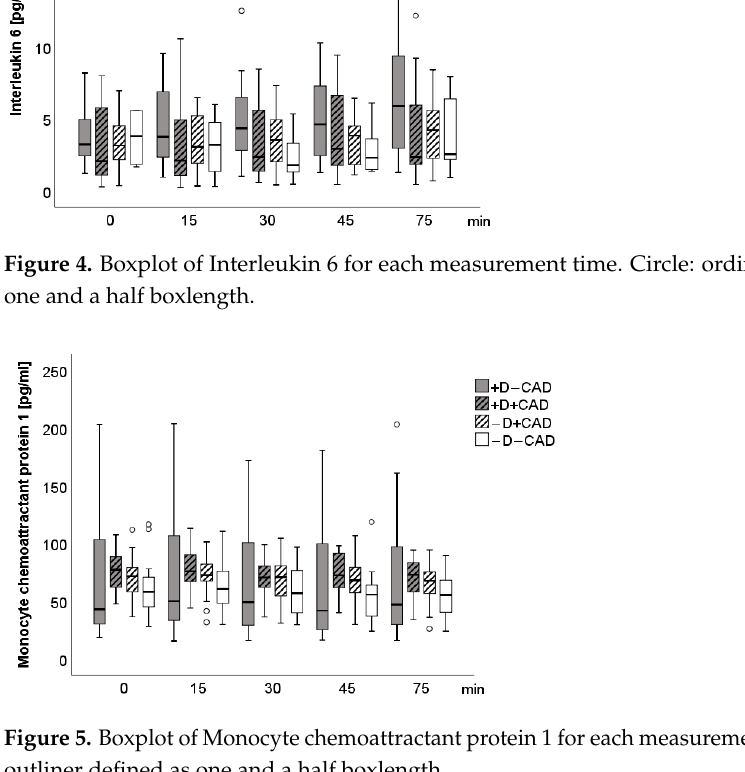
Figure 5. Boxplot of Monocyte chemoattractant protein 1 for each measurement time. Circle: ordinary outliner defined as one and a half boxlength, asterisk: extreme outliner defined as above one and a half to threefold boxlength.